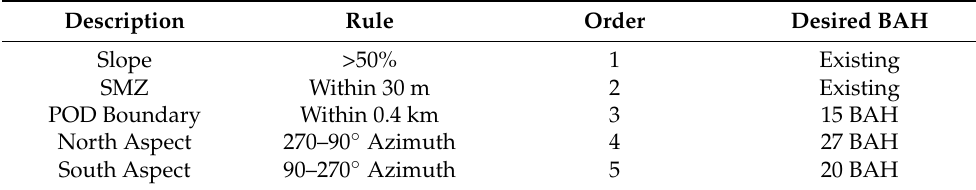
Figure 3. The process flow used to spatially identify the desired future condition (DFC) expressed as basal area ha − 1 (BAH). A digital elevation model (DEM), potential operational delineations (PODs), stream side management zones, and the dominant forest classification were used as inputs within a batch processing spatial modeling framework [25,62] to identify cells meeting Table 4 criterion. Raster surface cells meeting specified criterion were populated with the corresponding desired BAH. Orange collaborative forest landscape restoration program polygons are displayed for reference in the DFC graphic. Table 4. Desired basal area ha − 1 (BAH) for the Pine and Fir * dominant forest cover types. Pro- cessing order identifies the priority of desired BAH threshold, in shared areas, given the selection rule.